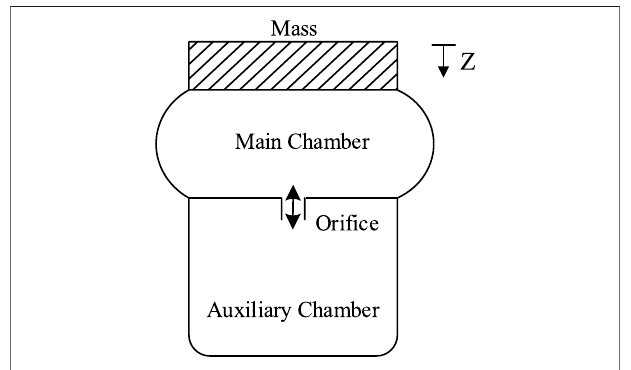
FIGURE 1 | Schematic of an air spring with an auxiliary chamber.